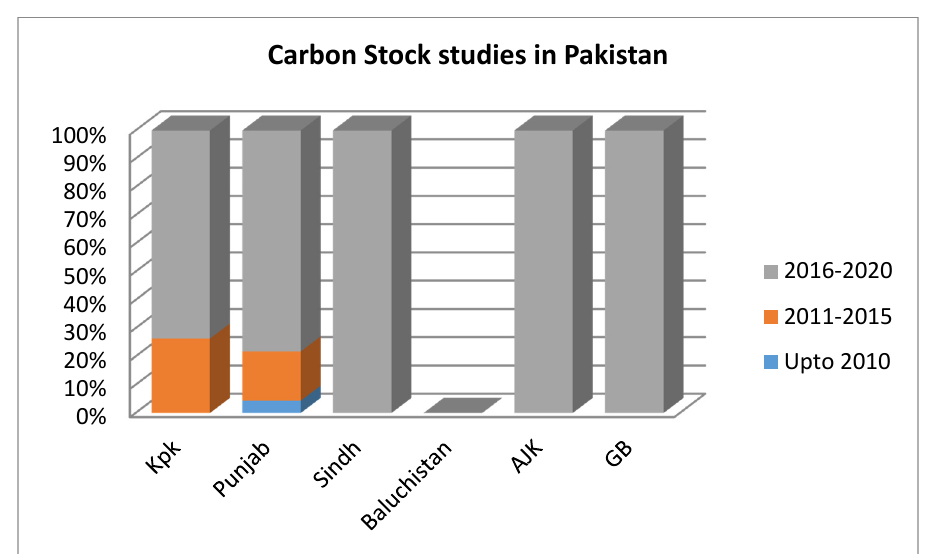
Figure 2. Graphical bars show the estimated carbon stock studies in Pakistan. Kpk = Khyber Pakhtunkhwa, AJK = Azad Jammu and Kashmir, and GB = Gilgit Baltistan Table 3. Current status of each territory with respect to above-ground biomass (AGB) and carbon stock studies. Prov- ince/Territory